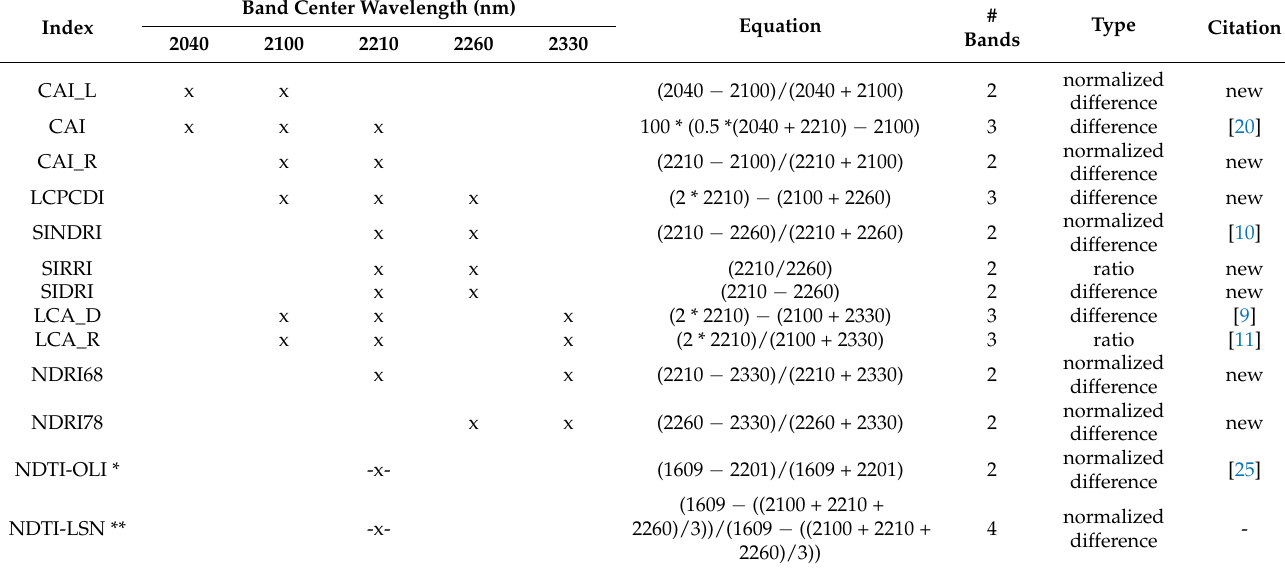
Table 1. Equations for the 13 calculated shortwave infrared (SWIR) reflectance indices: CAI-L-Cellulose Absorption Index (left shoulder); CAI-Cellulose Absorption Index; CAI-R-Cellulose Absorption Index (right shoulder); LCPCDI-Cellulose Side Peak Difference Index; SINDRI–Shortwave Infrared Normalized Difference Residue Index; SIRRI–Shortwave Infrared Ratio Residue Index; SIDRI–Shortwave Infrared Difference Residue Index; LCA_D-Lignin Cellulose Absorption Difference Index; LCA_R-Lignin Cellulose Absorption Ratio Index; NDRI68-Normalized Difference Residue Index (WV3 bands 6 and 8); NDRI78-Normalized Difference Residue Index (WV3 bands 7 and 8); NDTI-LSN-Normalized Difference Tillage Index (using convolved Landsat Next proposed bands along with OLI band 6 bandwidth mean reflectance calculated from hyperspectral dataset); NDTI-OLI-Normalized Difference Tillage Index (using OLI bands 6 and 9 bandwidth mean reflectance calculated from hyperspectral dataset).